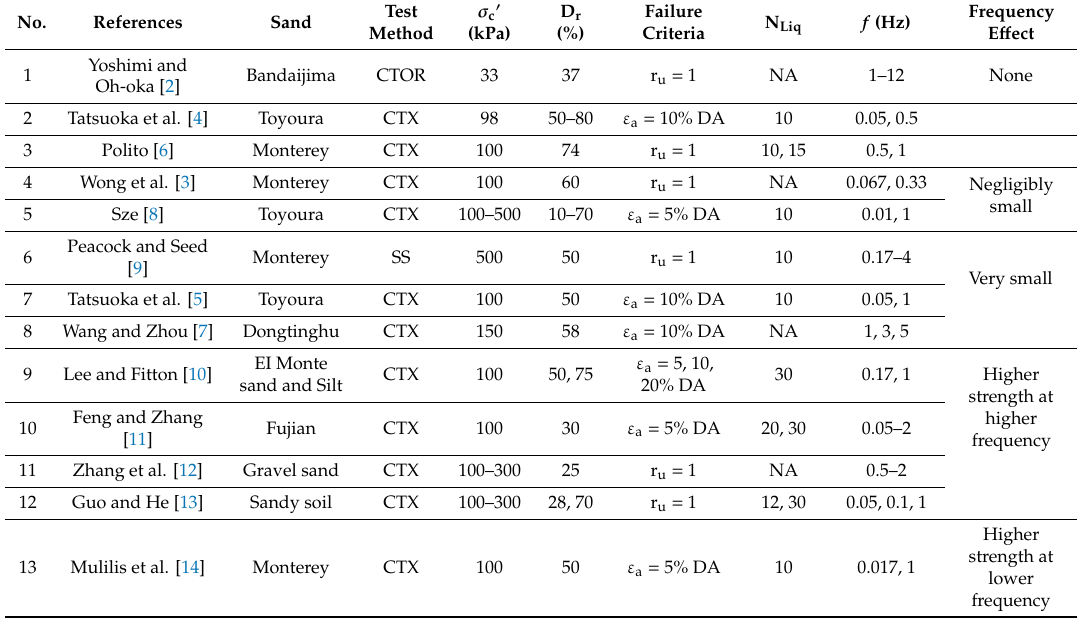
Table 1. Literature review on loading frequency e ff